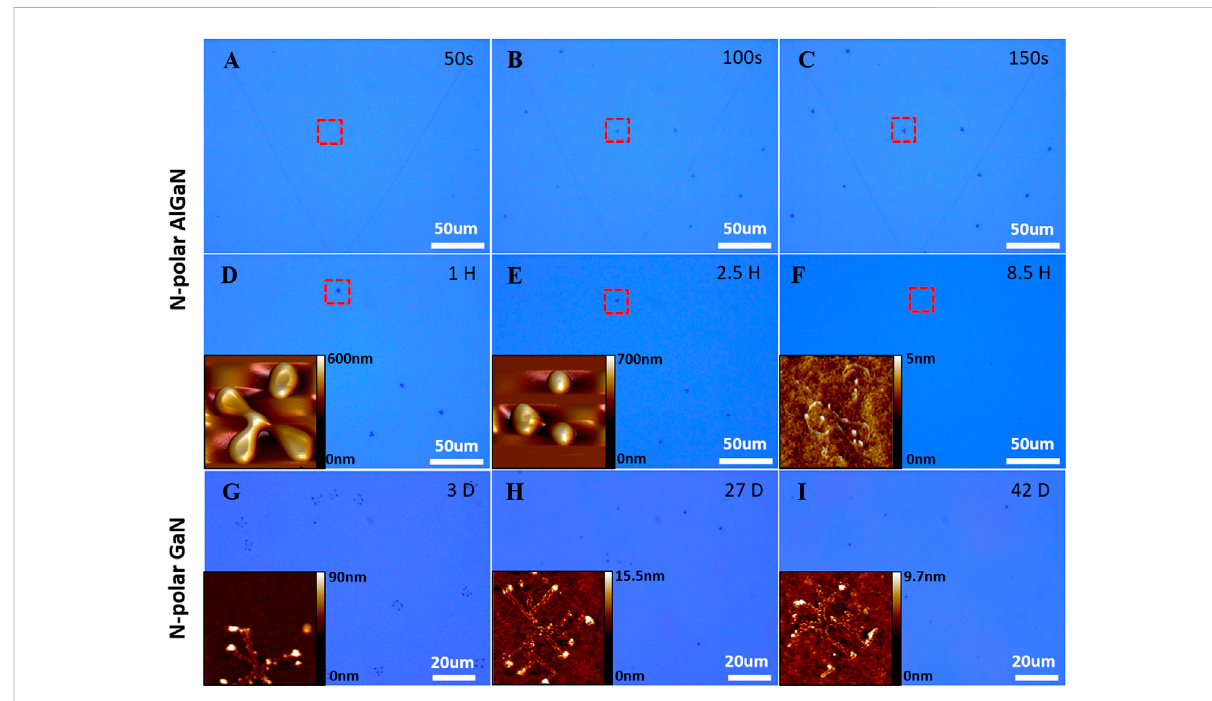
FIGURE 3 OMimages showingtheevolution processofsurfacedebriswhentheetching wasstopped ontheAl 0.4 Ga 0.6 Nlayer (A – F) andon theGaN layer (G – I) after the samples were exposed in air for a certain period of time. The inserted are 5 × 5 μ m 2 AFM images around the debris region outlined by the red boxes in the corresponding OM